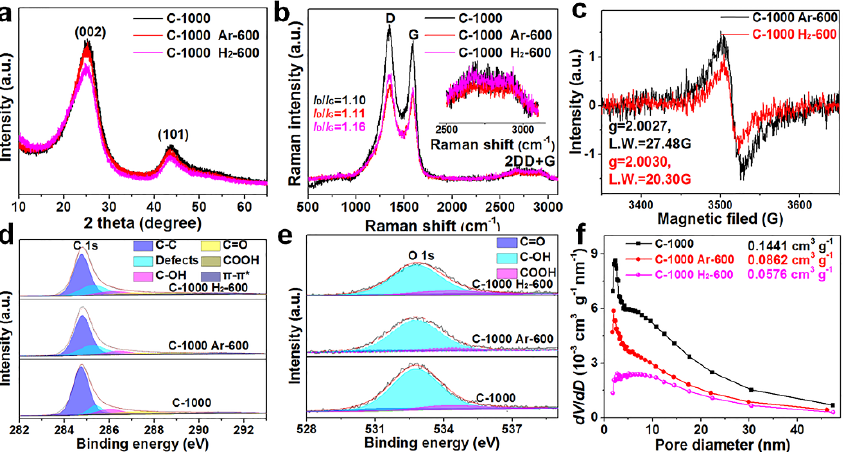
Figure 2. ( a ) XRD patterns of the three samples. ( b ) Raman spectra of the three samples. ( c ) EPR spectra of the three samples. XPS spectra of ( d ) C 1s and ( e ) O 1s of the three samples. ( f ) Pore size distribution of the three samples.